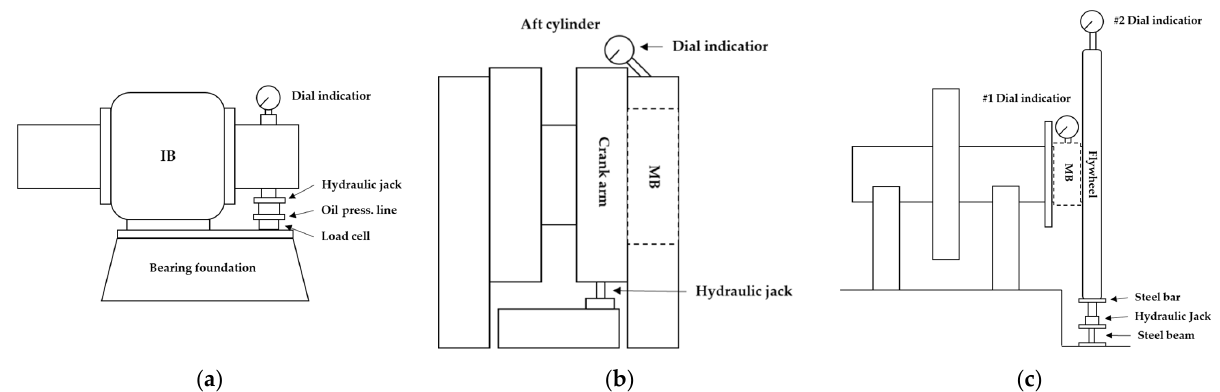
Figure 3. Measurement using jack-up method: ( a ) intermediate bearing (IB), ( b ) main bearings (MBs) excluding aftmost MB, and ( c ) aftmost MB.